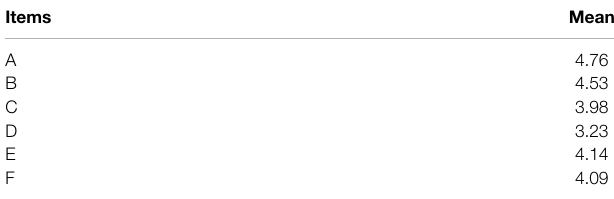
TABLE 1 | Teachers ’ attitudes toward various self-development courses. Items